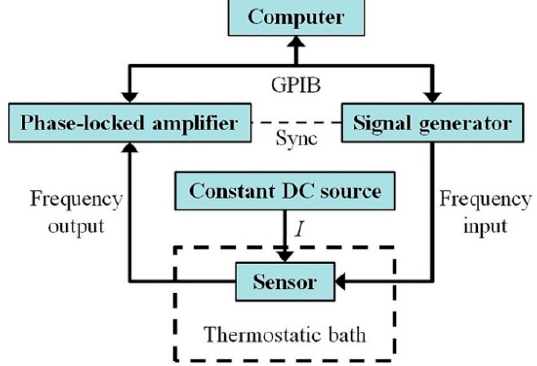
Figure 7. Block diagram of experimental system.